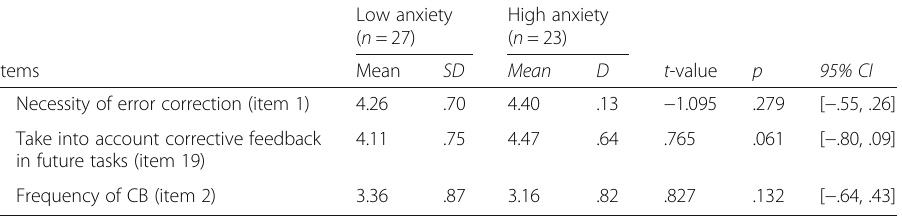
Low anxiety High anxiety ( n = 27) ( n = 23)